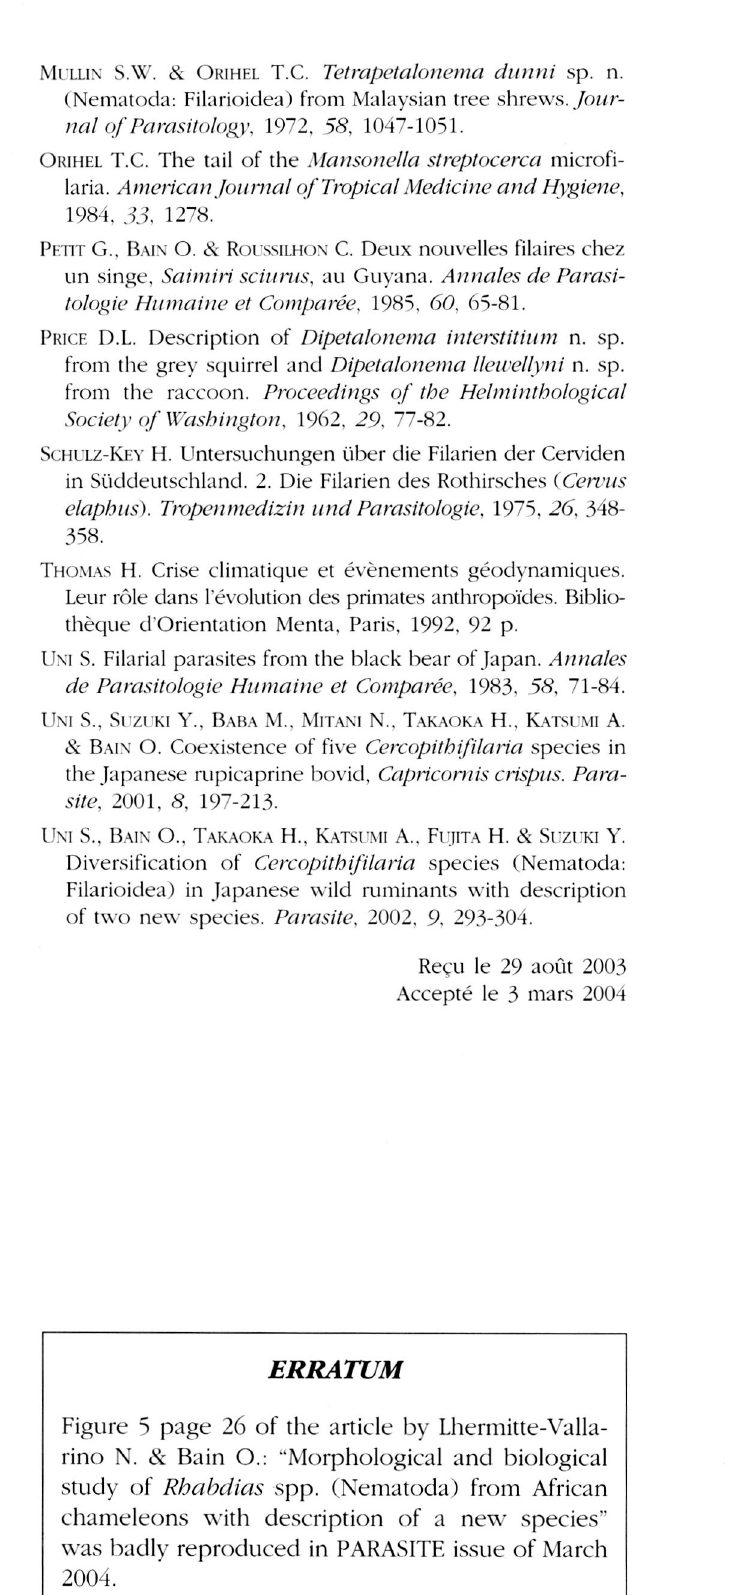
Figure 5 page 26 of the article by Lhermitte-Valla- rino N. & Bain O.: “Morphological and biological study of Rhahdias spp. (Nematoda) from African chameleons with description of a new species” was badly reproduced in PARASITE issue of March